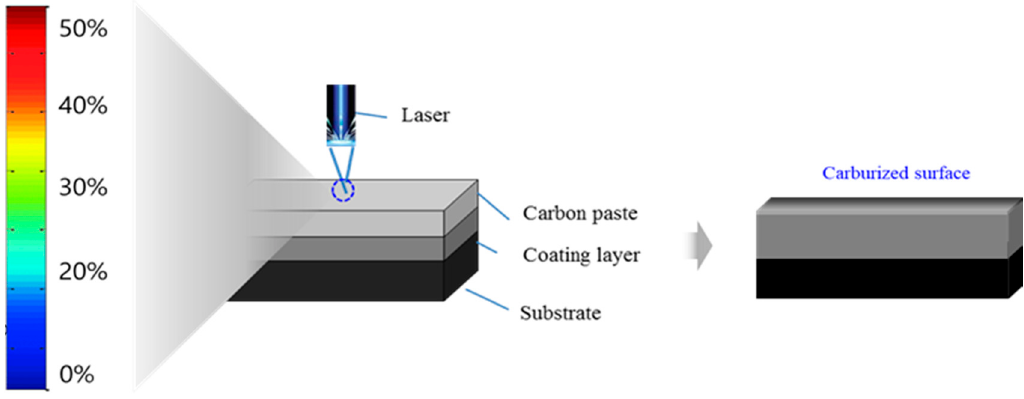
Figure 2. Schematic diagram of laser carburization of TiZrN coating.